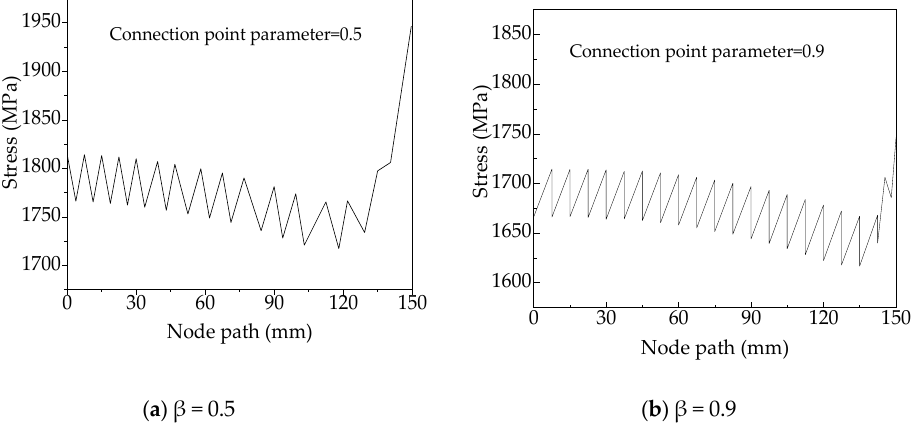
Figure 10. Stress distribution of variable-angle laminates of [0 ± < 20 ( β ) 60 >] 2s in the axial direction. ( a ) β = 0.5; ( b ) β = 0.9.